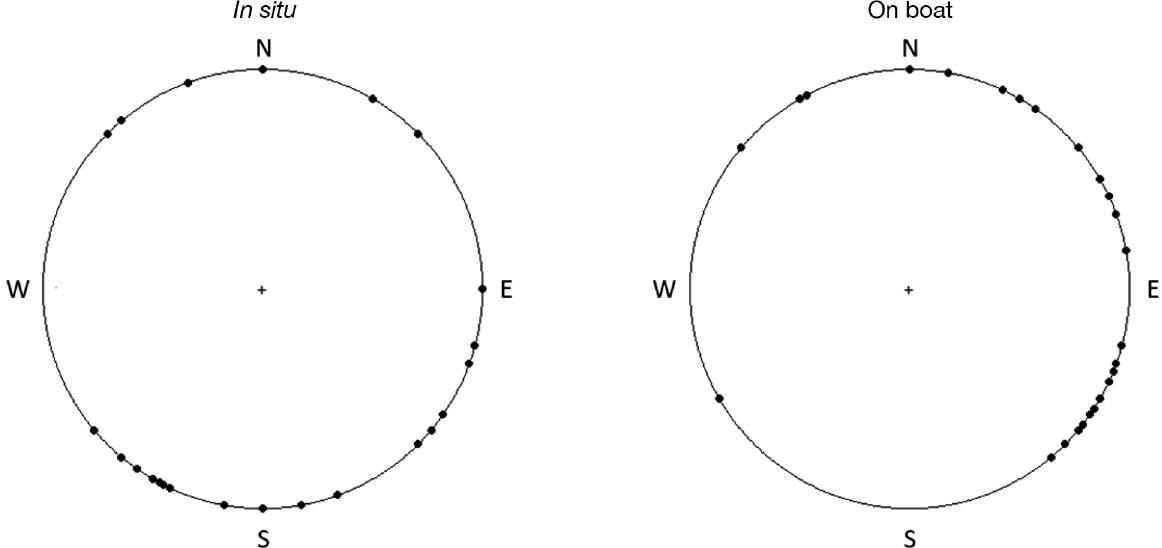
Fig. 3. Lobsters released at a center point and moving towards the edge of an acoustic array in 2017 according to tagging method. Dots represent individual lobsters (25 per tagging method) and their movement direction recorded 24 h